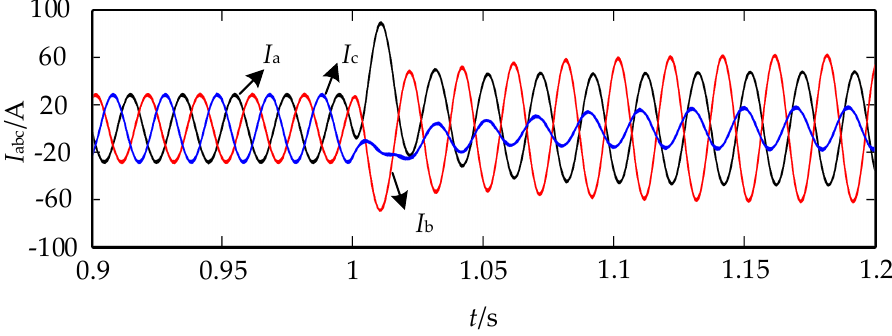
Figure 10. Three-phase currents with a PI current inner Figure 10. Three ‐ phase currents with a PI current inner loop.